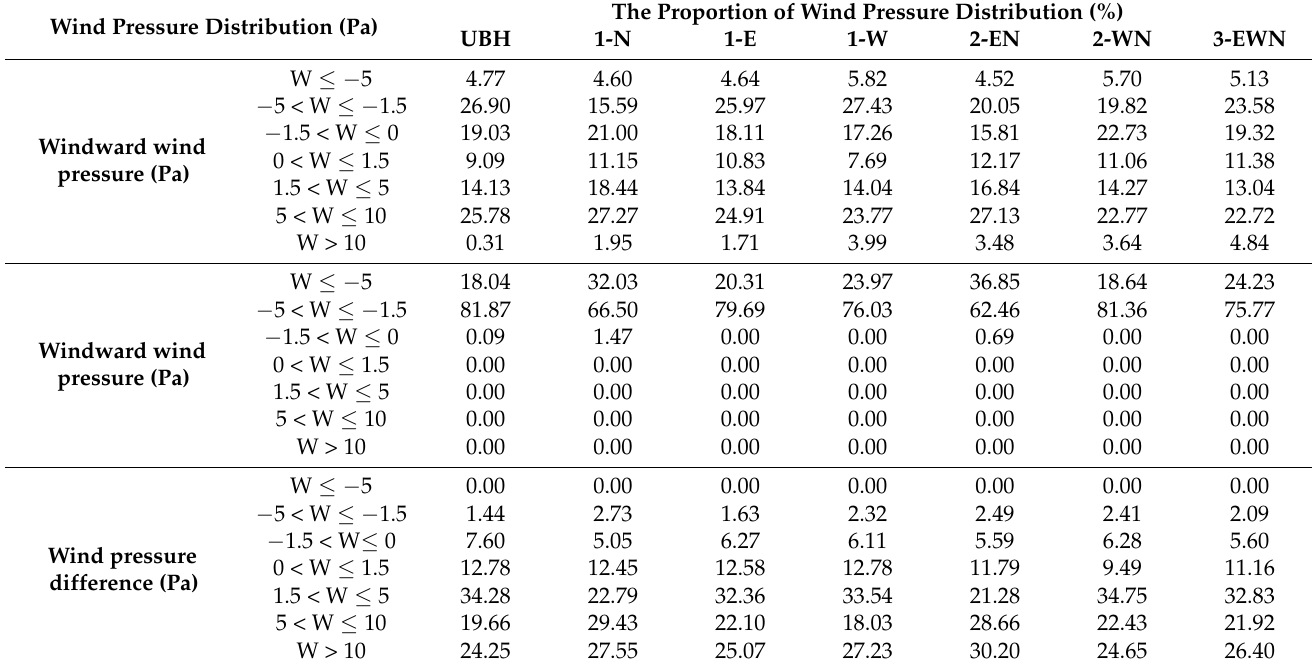
Table 5. Wind pressure ratios of seven building distribution